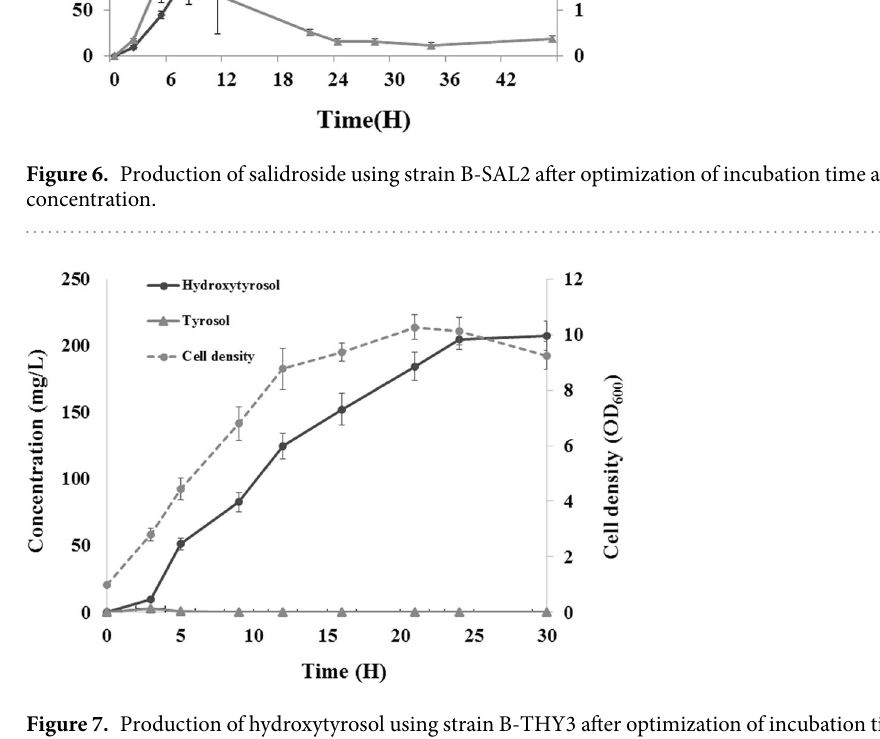
Figure 7. Production of hydroxytyrosol using strain B-THY3 after optimization of incubation time and cell